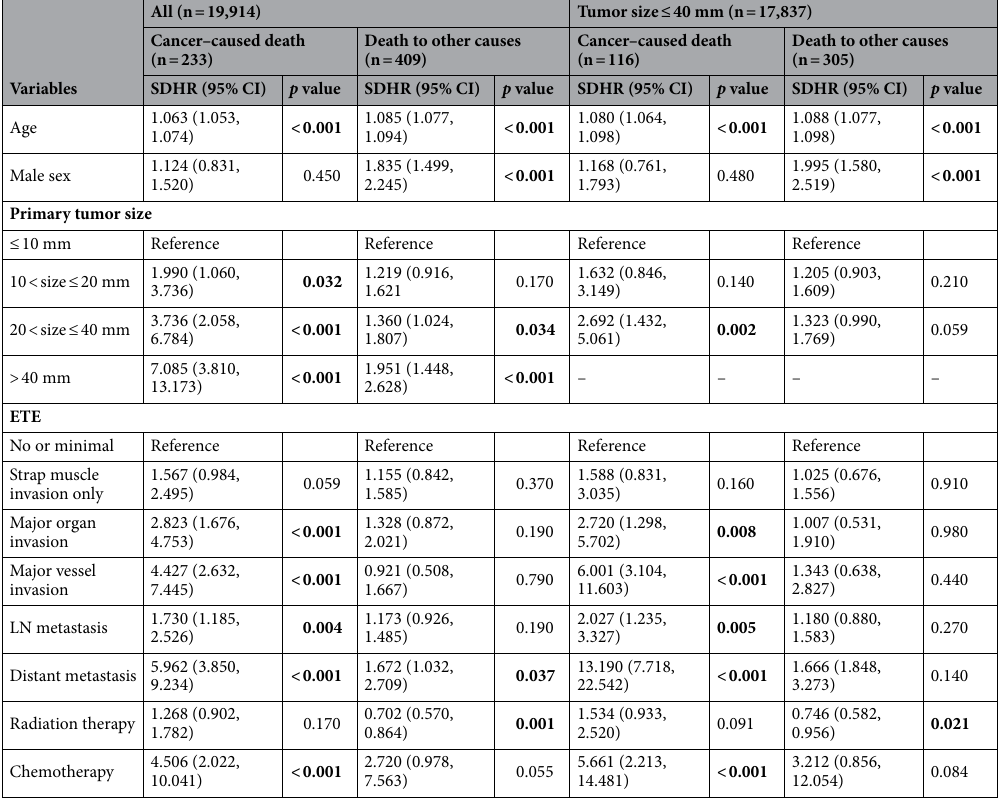
Table 4. Multivariable competing risk analysis of clinical and pathological variables for cancer–caused death according to the AJCC 8th TNM staging schema. Statistically significant values are shown in bold. DSS disease-specific survival, SDHR subdistribution hazards ratio, CI confidence interval, ETE extrathyroidal extension, LN lymph